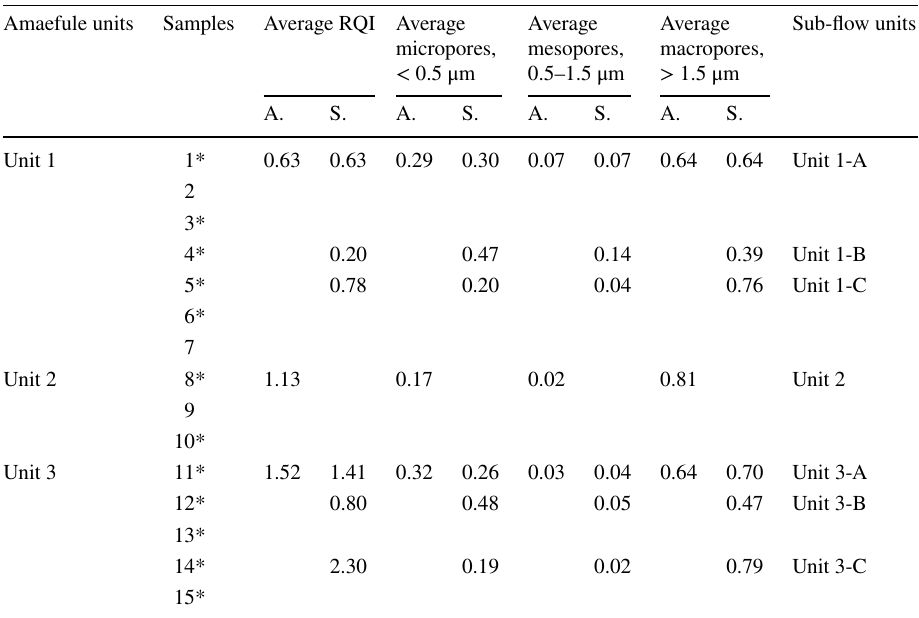
Table 4 Different capillary pressure-derived parameters and RQI for different flow/sub-flow